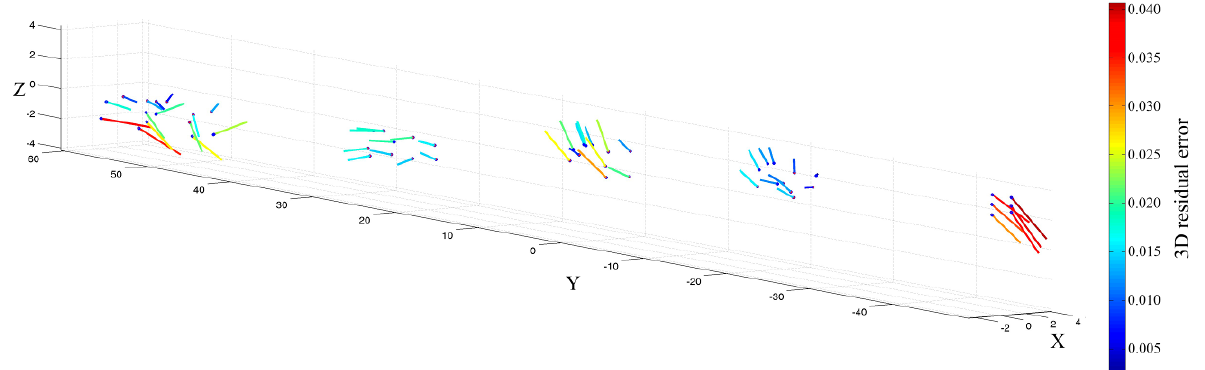
Figure 4. 3D residual error of the targets used to co-register all the TLS scans with a 6 parameters transformation. The standard deviations resulted: std X = 1.55 cm, std Y = 0.6 cm, std Z = 1.37 cm,